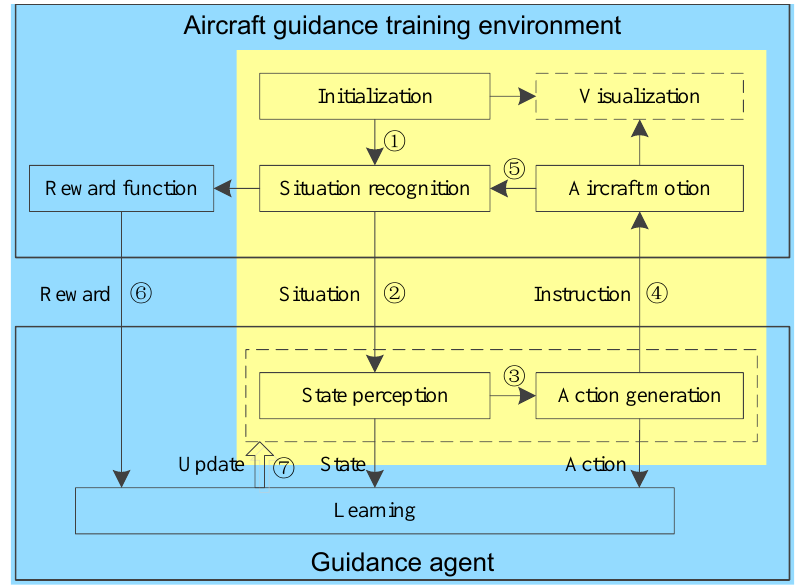
Figure 2. Aircraft guidance agent training